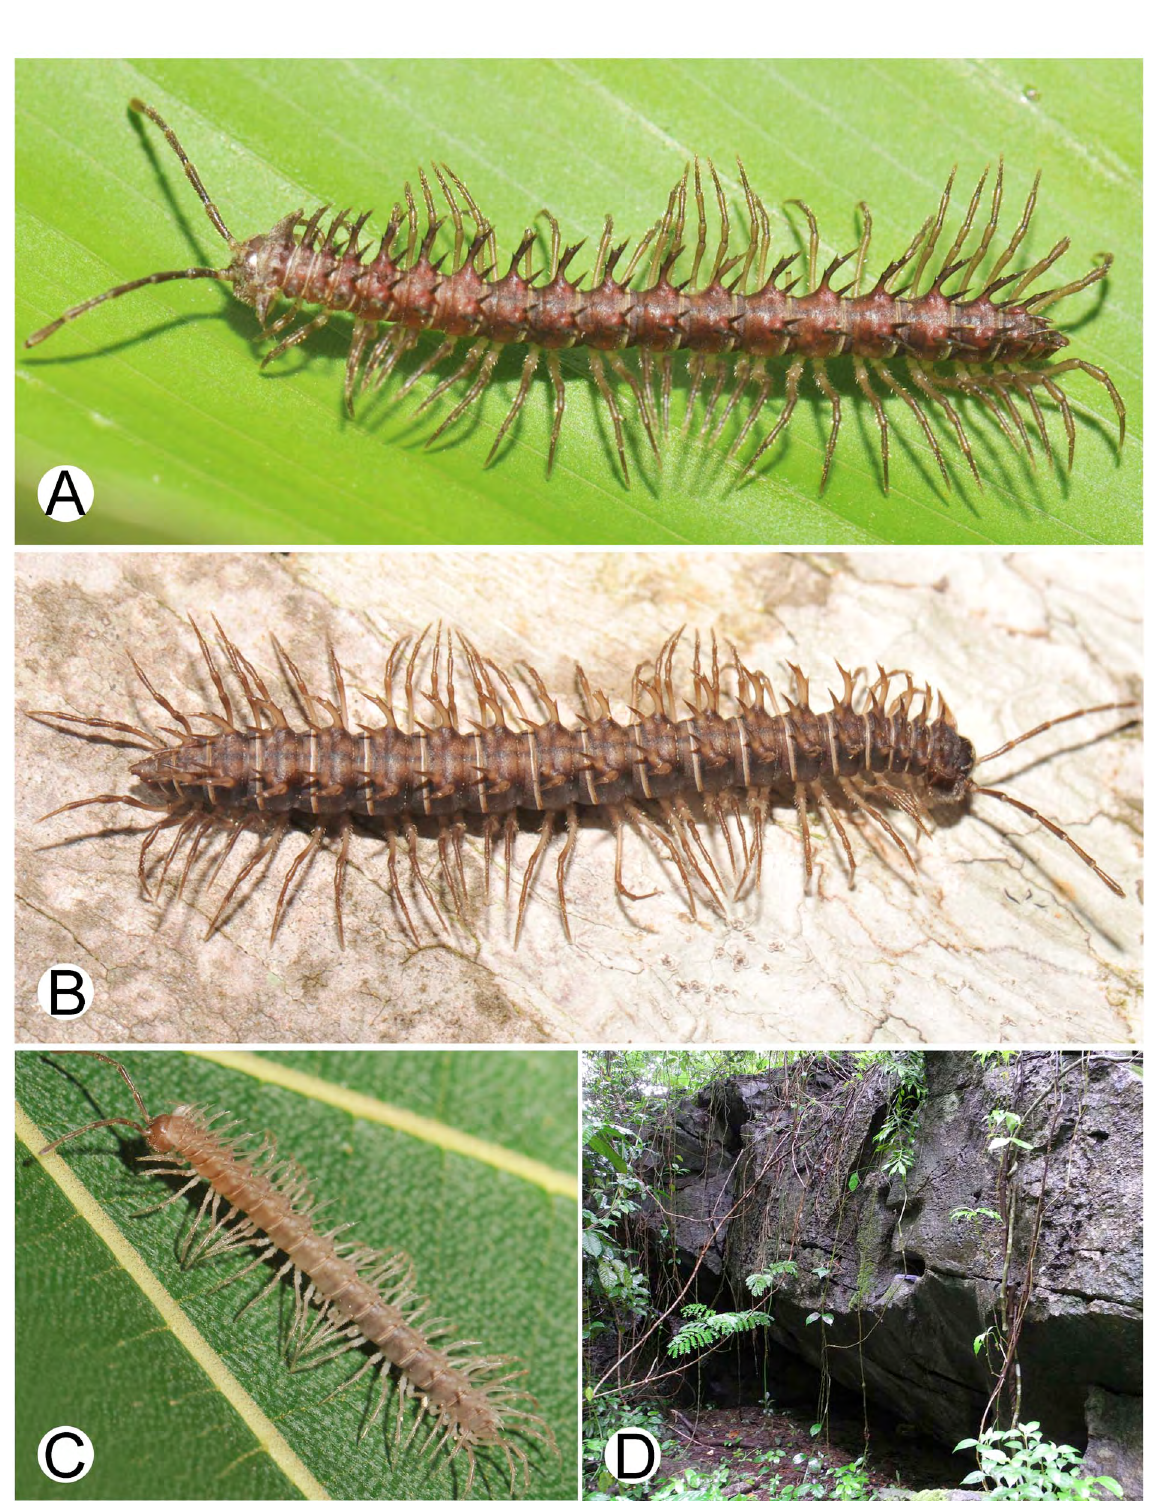
Fig. 22. Live photographs and habitat of Nagaxytes spatula Srisonchai, Enghoff & Panha gen. et sp. nov. (specimens from Chao Por Phawo Shrine, Thailand). A . ♂, paratype (CUMZ-pxDGT00120). B . ♀, paratype (CUMZ-pxDGT00147). C . ♂, paratype (CUMZ-pxDGT00146), newly moulted adult. D .